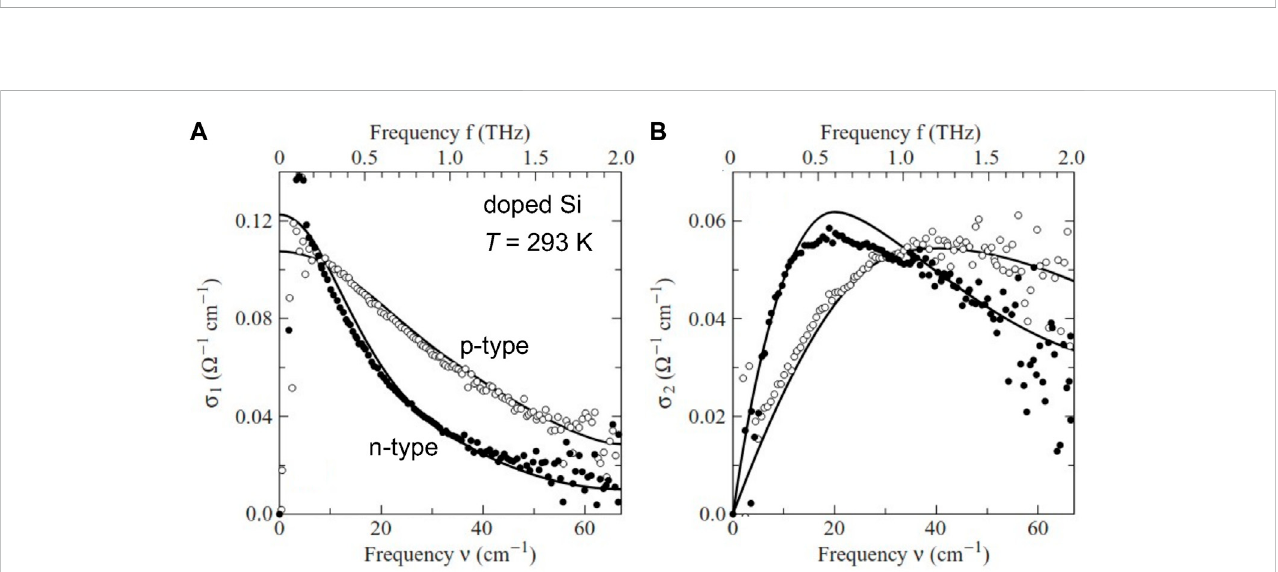
FIGURE 2 Frequencydependenceofthe (A) realand (B) imaginarypartsoftheopticalconductivityofsilicon,weaklydopedbyholes(1.1 · 10 15 cm − 3 ,opencircles) or electrons (4.2 · 10 14 cm − 3 , solid circles). The experiments were performed at T = 293 K in the time domain; the full lines correspond to Drude fi ts (see text). Figure adapted from (Dressel and Grüner, 2002), with original data and Drude fi ts from (van Exter and Grischkowsky,